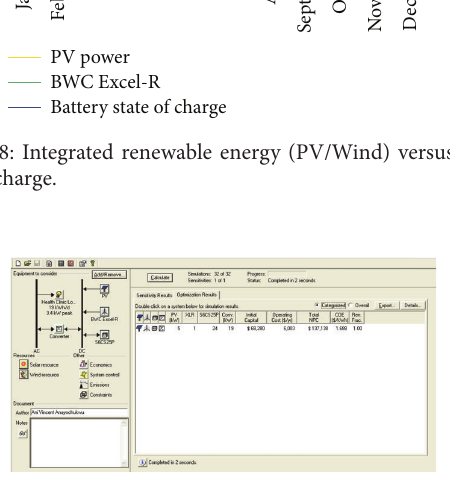
Figure 9: The network architecture for the HOMER simulator, proposed PV/wind power system and its optimization results.